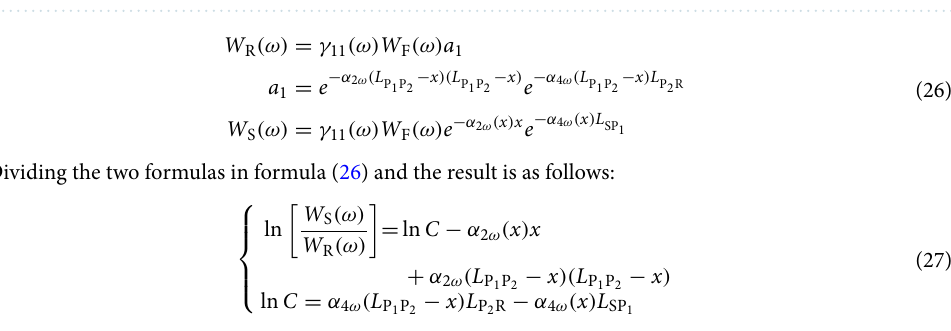
Figure 10. ( a ) Voltage traveling wave waveform at S-end and R-end of the line; ( b ) Current traveling wave waveform at S-end and R-end of the